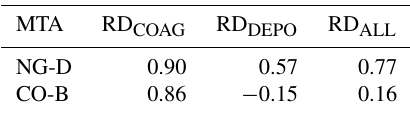
Table 4. Linear correlations between the relative differences and the MTAs for NG-D and